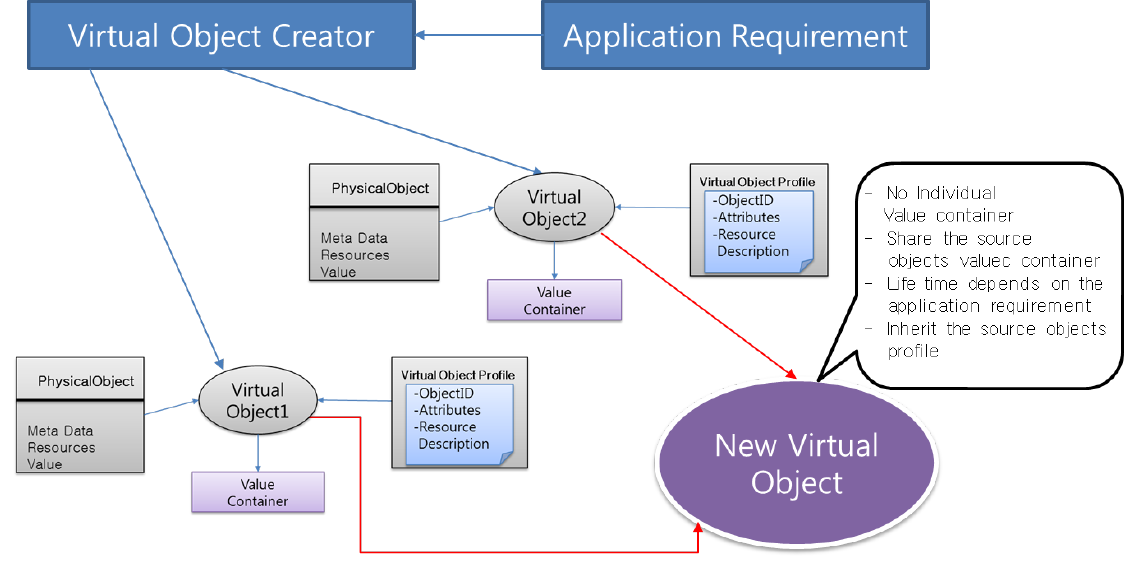
Figure 6. Two ViOs are combined to create a new ViO. Virtual objects have a profile and value container to keep the recent value. But the New ViO does not have any value container as it inherits all the properties of its source